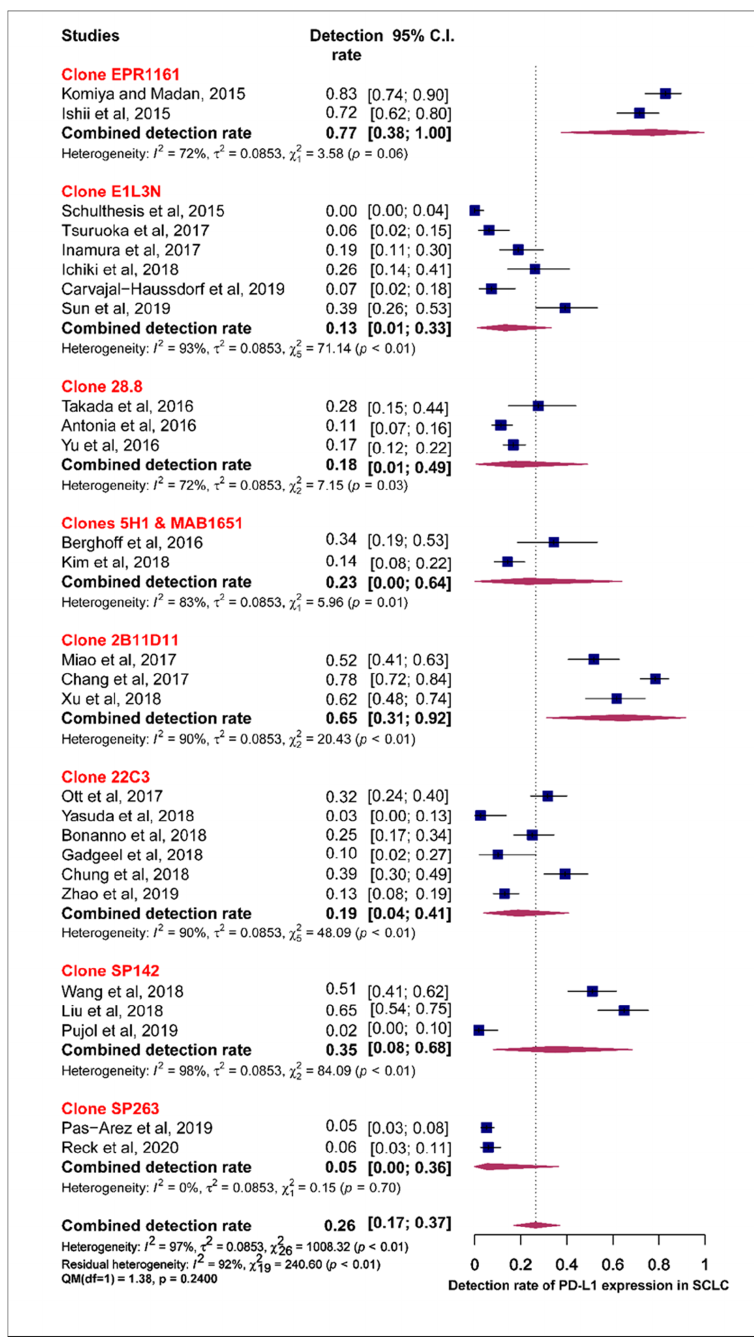
Figure 6. Forest plot of subgroup analysis of the association between the type of antibody and prevalence of PD-L1 expression. The PD-L1 detection rates and 95% CI of each study are represented with a horizontal line and the square area mirrors the size effect of each study. Highlighted in red are the antibody clones from FDA approved PD-L1 assays.